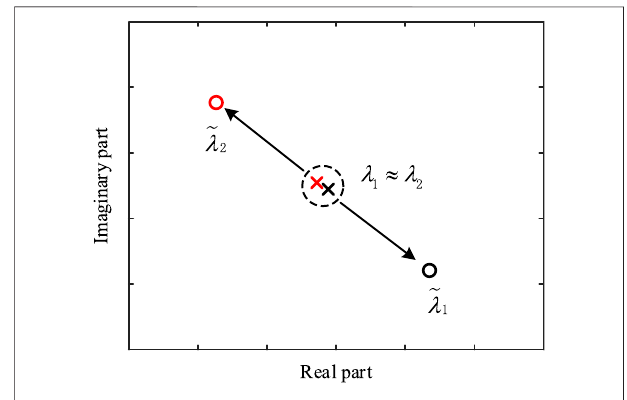
FIGURE 2 | The phenomenon of